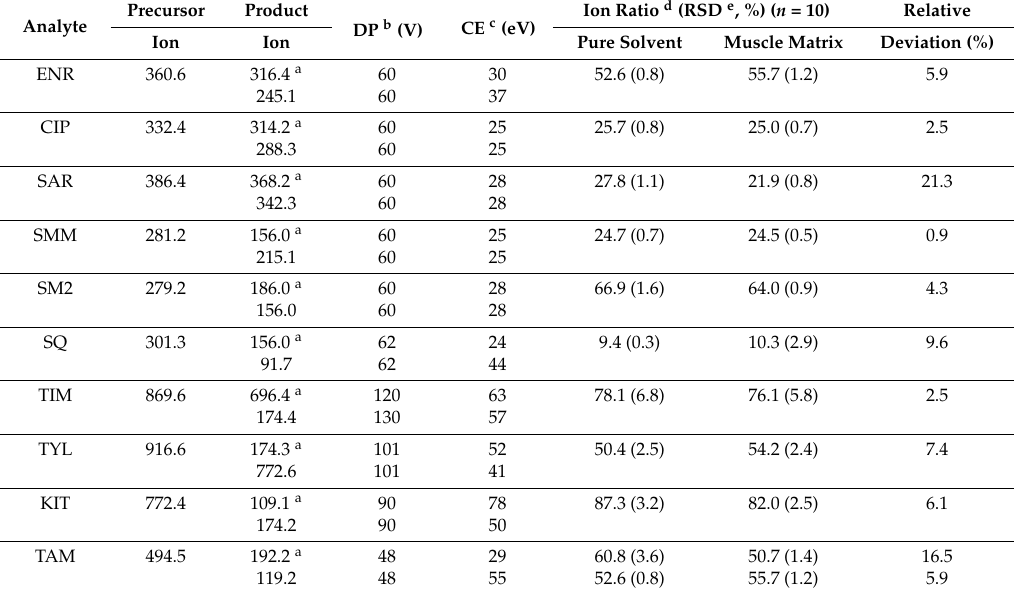
Table 1. LC-MS/MS conditions for 10 analytes in the SRM positive ion